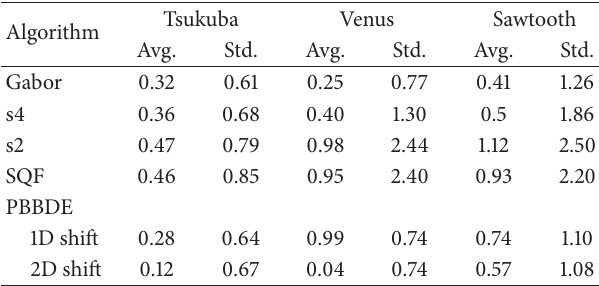
Table 1: Quantitative comparison (average and standard deviation of the absolute errors in pixels) in disparity estimation between different band-pass representations on Middlebury images